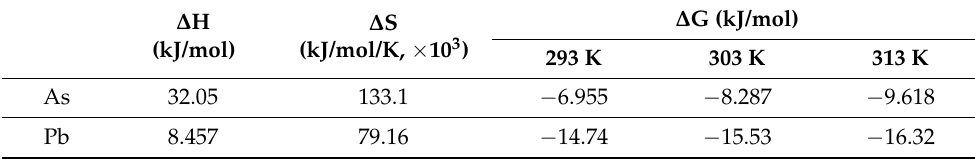
Figure 7. Temperature effects on ( a ) As and ( b ) Pb adsorption. Table 7. Thermodynamic parameters for the adsorption of As and Pb onto the